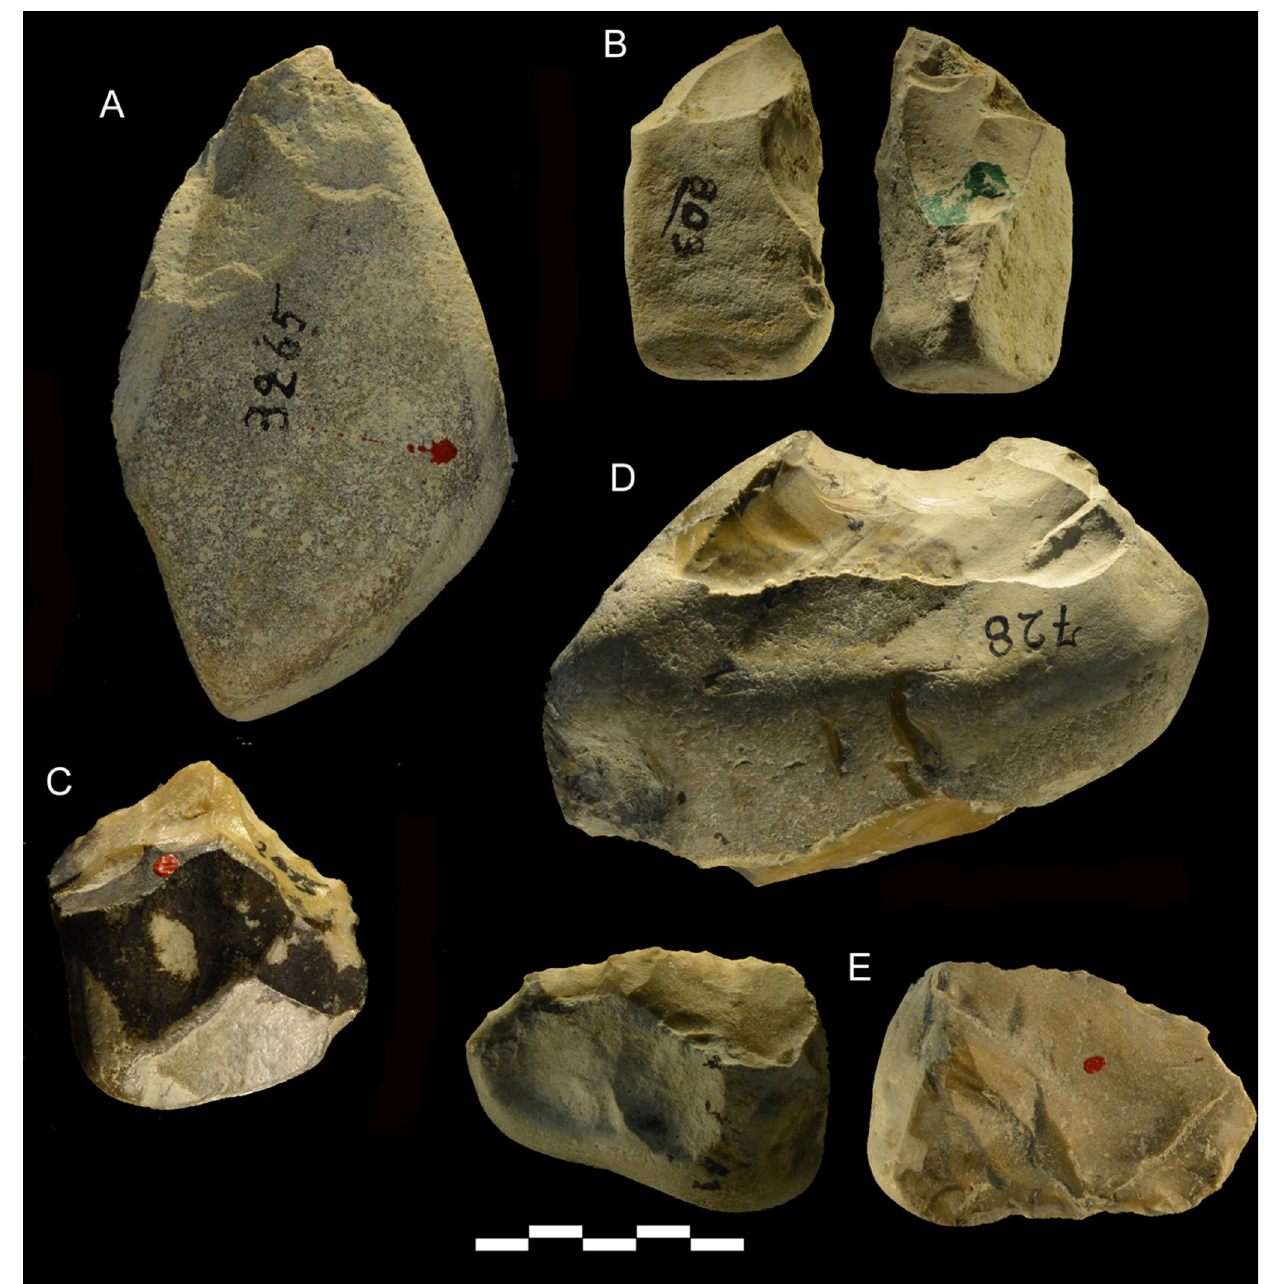
Fig 18. Castel di Guido lithics. A, B, E of chert, C, D of flint; (A, B, C) pointed tools; (D) retouched notch; (E) scraper edge on core. Catalogue numbers 3265, 803, 2915, 728, 3208. Scale bar 5 cm.